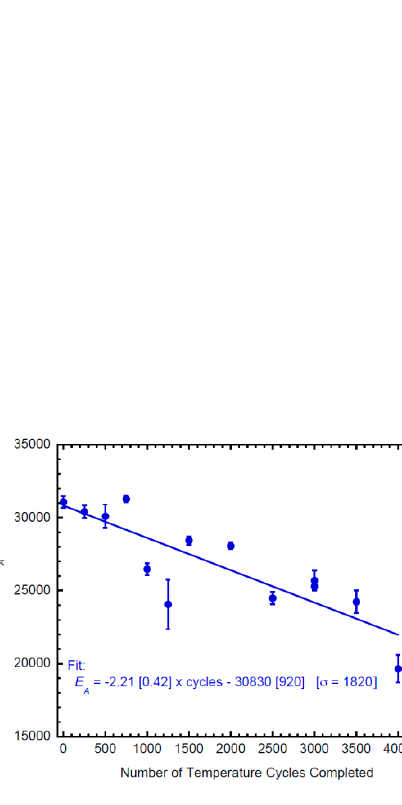
Figure 3. Relationship of pre-exponential scaling factor and activation energy of Arrhenius equation with temperature cycling intervals [28].